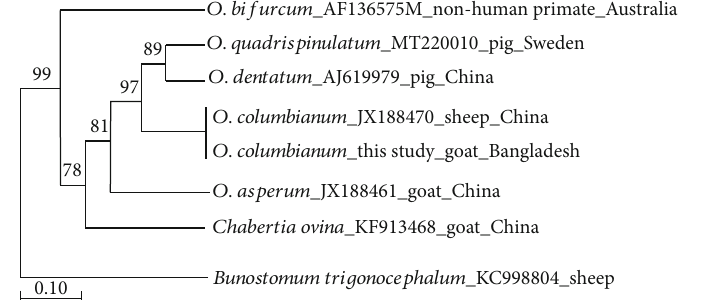
Figure 2: Phylogenetic relationships of present specimen ( O. columbianum ) with other members of Oesophagostominae reconstructed by ML method based on the ITS sequences. Bootstrap values are shown above branches. The scale bar represents 0.10% divergence.